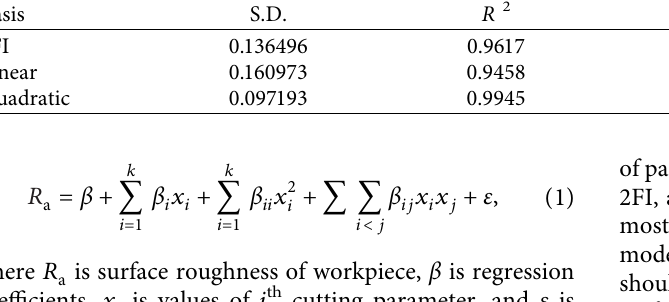
Table 4: Experimentation outcome on R